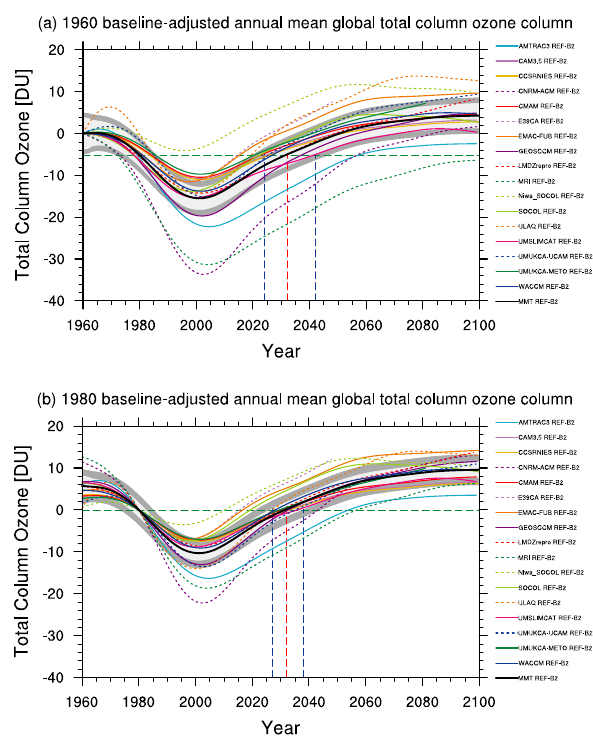
Fig. 1. (a) 1960 and (b) 1980 baseline-adjusted annual mean global total ozone column from the 17 reference simulations (REF-B2). The thick black line shows the multi-model mean and the light- and dark-grey shaded regions show the 95% confidence and 95% pre- diction intervals, respectively. The red vertical dashed line indicates the year when the multi-model mean returns to 1980 values and the blue vertical dashed lines indicate the uncertainty in these return dates. The green horizontal dashed line refers to the 1980 baseline, which may differ from zero when referenced to another year, e.g. 1960 as in panel